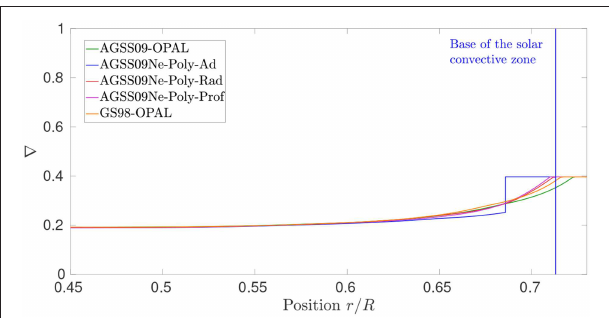
FIGURE 9 | Gradient of the natural logarithm of temperature with respect to the natural logarithm of pressure for the modified solar models considered in this